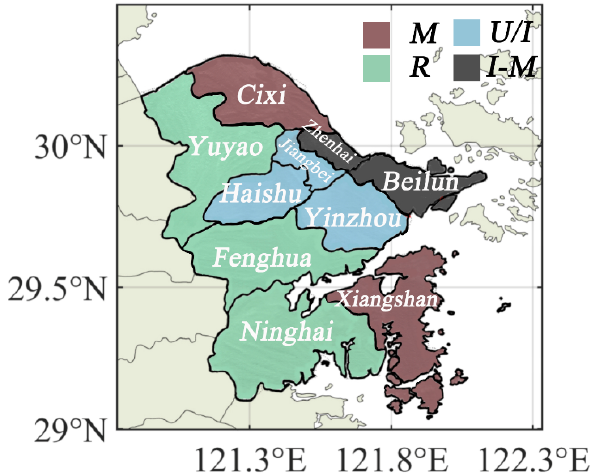
Figure 7. Atmospheric environment division of Ningbo’s districts and counties.